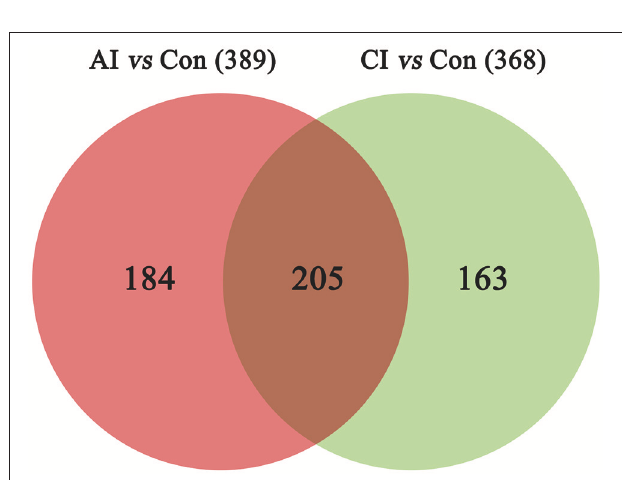
FIGURE 4 | A Venn diagram showing the common and unique metabolites between the acutely and chronically infected mice vs. control. In total, 389 metabolites were found during acute infection vs. control (red); and 368 metabolites were identified in chronically infected mice vs. control (green), 205 of which were shared between the two